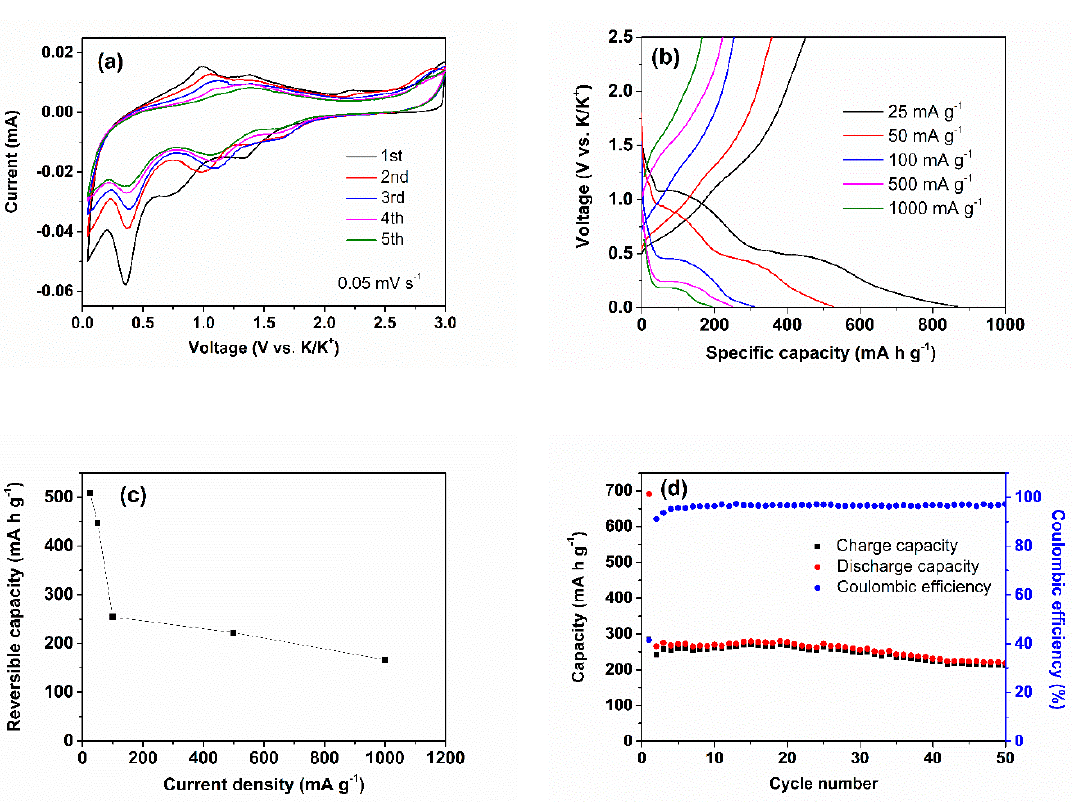
Figure 4. Electrochemical performance of the Sb 2 S 3 / CNT anode for K-ion batteries (KIBs). ( a ) CV curves, ( b ) the galvanostatic discharge-charge curves at various current densities, ( c ) rate capability and ( d ) cycling performance at 500 mA g − 1 . Table 2. Comparison of the electrochemical performances of the amorphous Sb 2 S 3 / CNT nanocomposites in this work, and those previously reported for Sb 2 S 3 -based anodes for KIBs.